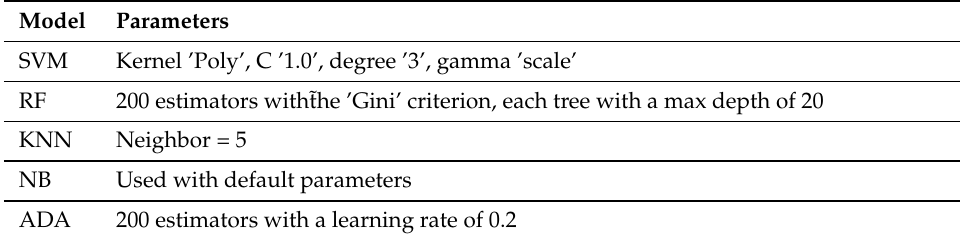
Table 2. Hyperparameter settings and performance of machine-learning models for COPD classification.